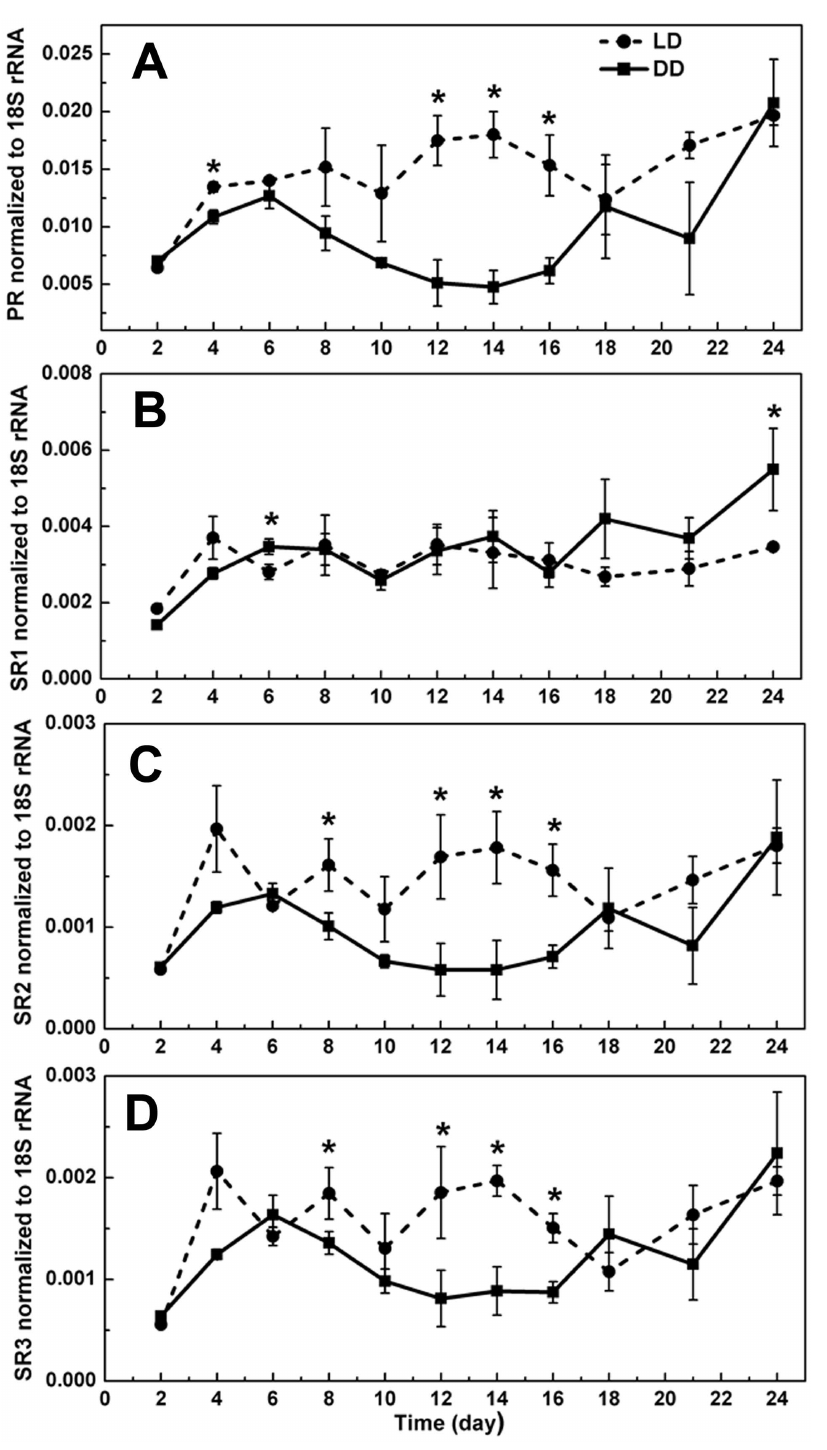
Fig. 3. Expression levels of rhodopsin genes as normalized to 18S rRNA cDNA. LD, cultures grown under light: dark cycle; DD, cultures grown under continuous darkness; error bars, standard deviation. (A) PR; (B) SR1; (C) SR2; (D) SR3. Significant differences between LD and DD groups were marked with